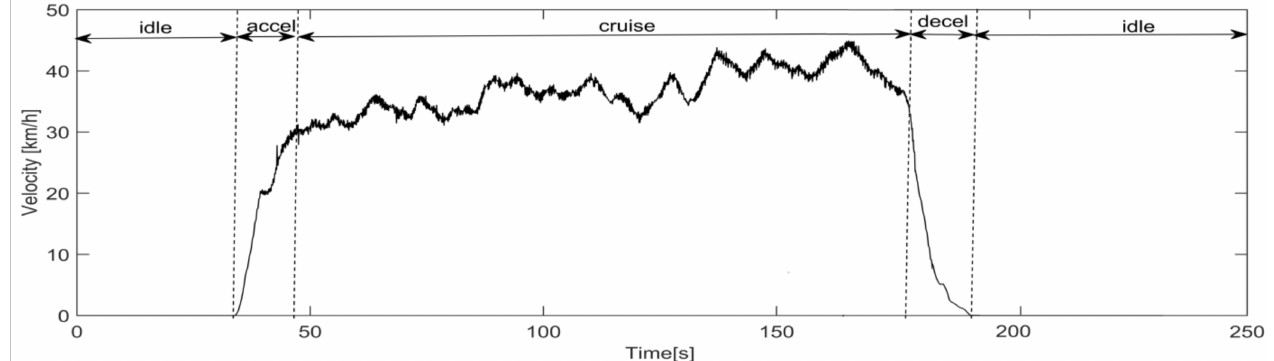
Figure 6. Four DP phases (acceleration, cruise, deceleration, and idle